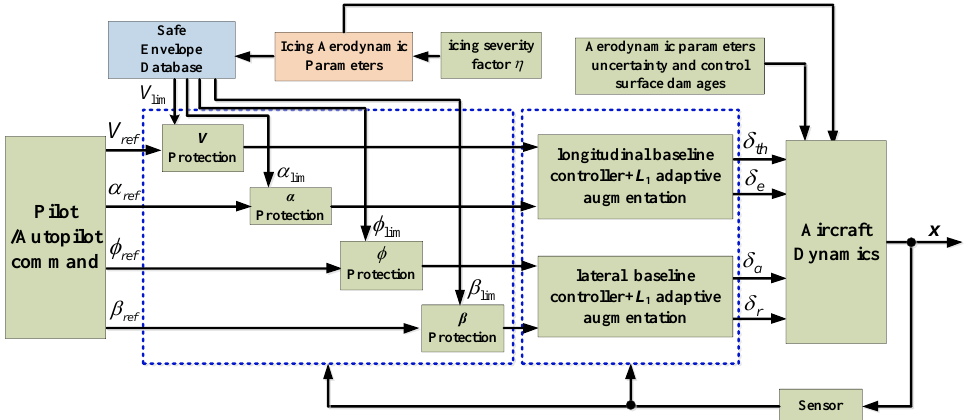
Figure 6. Flight safety envelope curve for clean configuration/heavy-icing configuration with differ- ent sideslip angles.